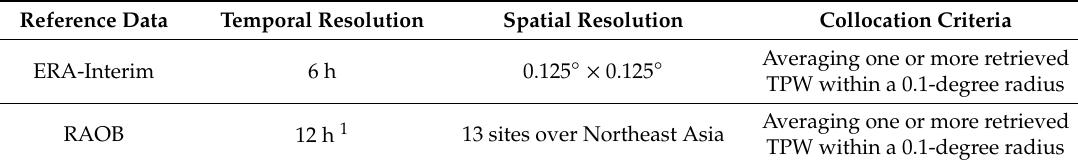
Table 4. Description of reference data and collocation criteria for the validation of the proposed